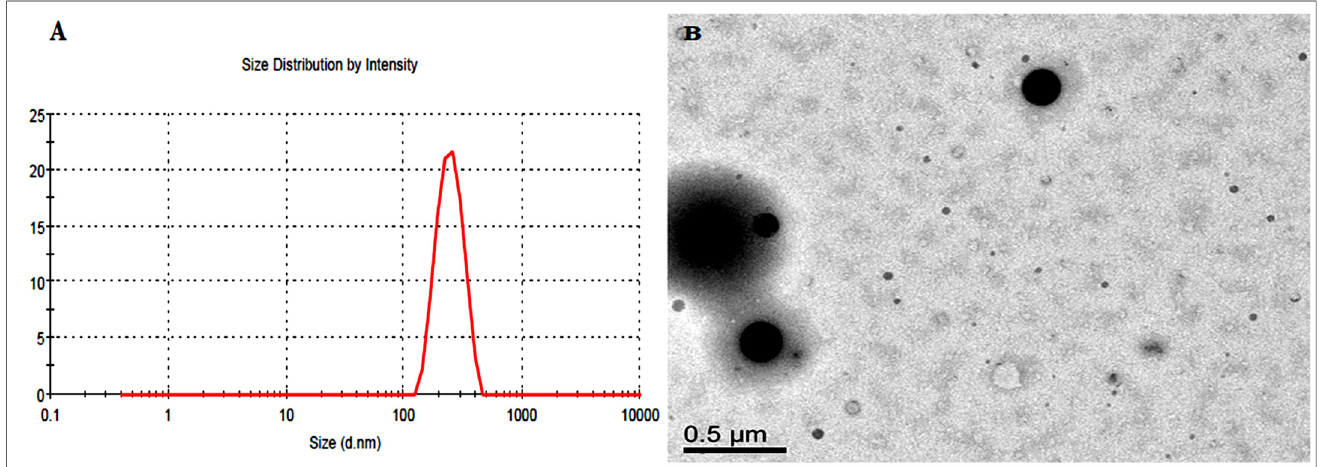
Figure 4. Globule size image ( A ). TEM image ( B ) of optimized CEP-SNEDDS